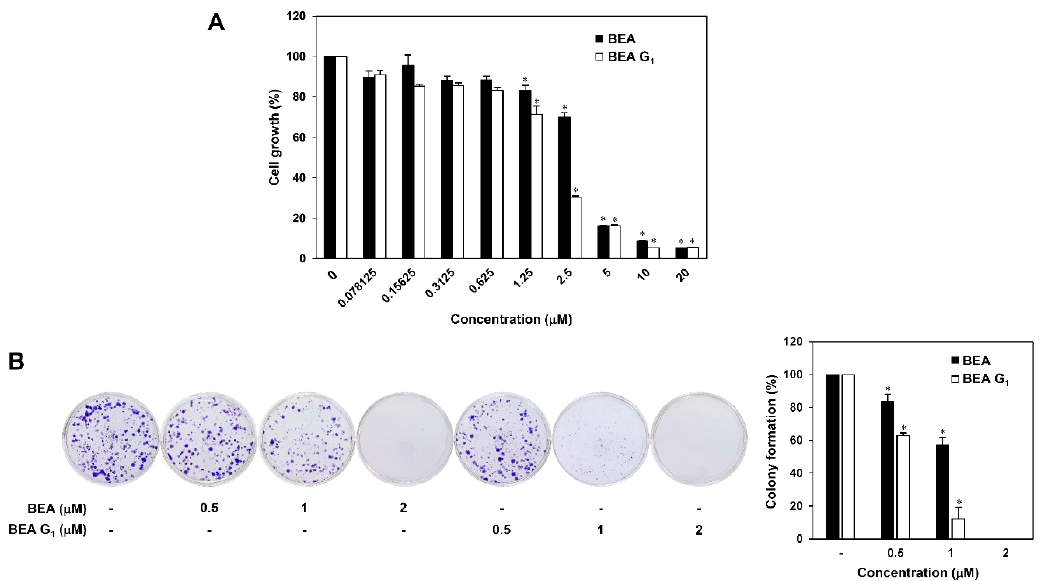
Figure 2. Growth inhibitory effects of BEA and BEA G 1 on A375SM melanoma cells. ( A ) The effects of BEA and BEA G 1 on the growth of A375SM cells. The cells were treated with increasing concentrations of BEA and BEA G 1 (0–20 µ M) for 72 h, and cell growth was measured by a 3-(4,5-dimethylthiazol-2-yl)-2,5-diphenyltetrazolium bromide (MTT) assay. ( B ) The effects of BEA and BEA G 1 on the colony-forming ability of A375SM cells. The cells were treated with BEA and BEA G 1 (0.5, 1, and 2 µ M) and incubated for 10 days. The cell colonies were visualized by crystal violet staining and then counted. * = p < 0.05 versus the control.